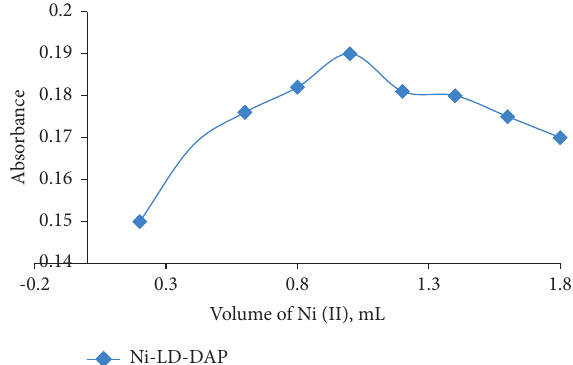
Figure 3: Effect of Ni(II) volume on the maximum absorbance signal of LD.